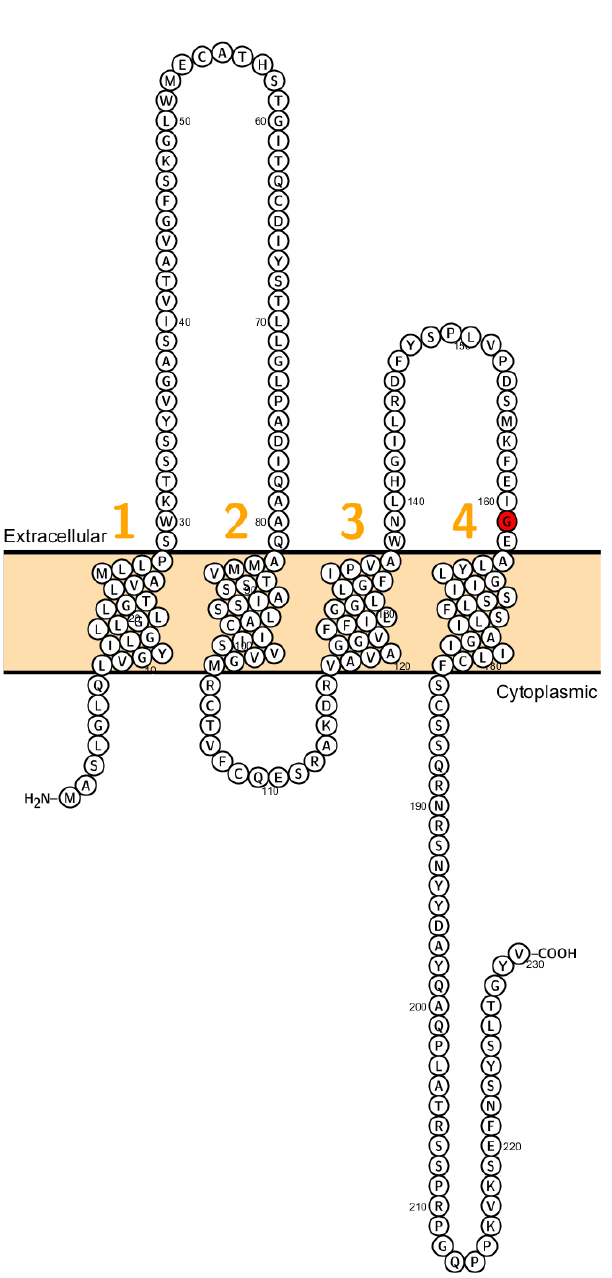
Figure 2. Topology of CLDN2 . FASTA sequence of CLDN2 (Uniprot accession no: P57739). Each amino acid is shown as a single letter code and numbers (orange) indicate transmembrane domains. Mutations shown to be involved in human diseases are shown in red.